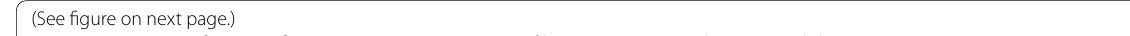
figure on next Fig. 7 Comparison of immunofluorescence staining pictures of hippocampus in each group. Red shows Lamp2 protein expression, green shows COXIV expression, blue is the labeled nucleus. a Immunofluorescence pictures of Lamp2 and COXIV of rats in each group magnification Average fluorescence intensity of Lamp2 of rats in each group. c Average fluorescence intensity of COXIV of rats in each group. * p < 0.05 versus control group; # p < 0.05 versus model group; △ p < 0.05 versus EA